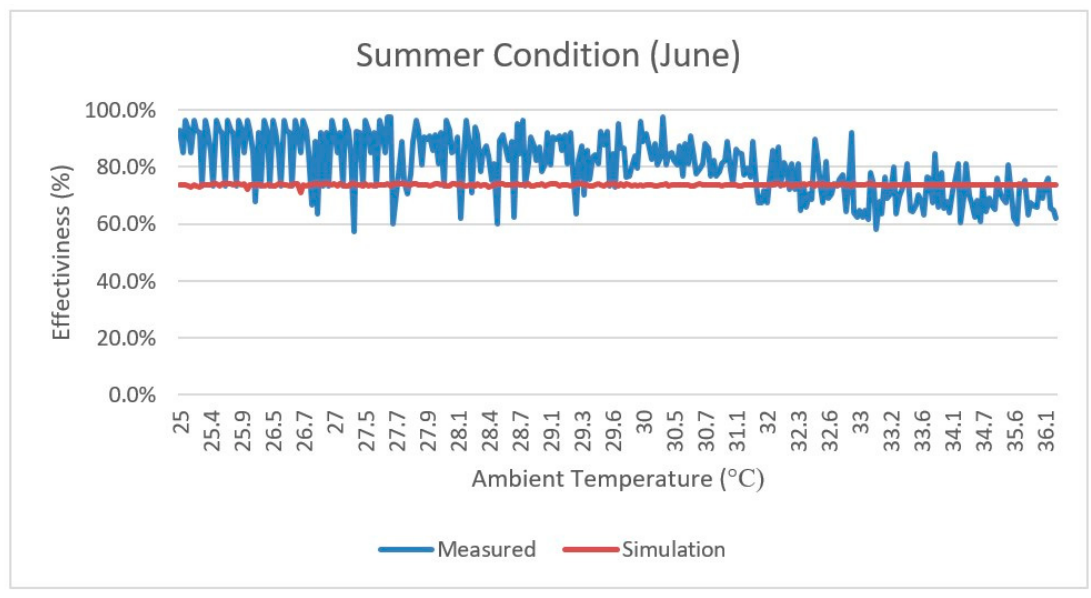
ff ectiveness values in